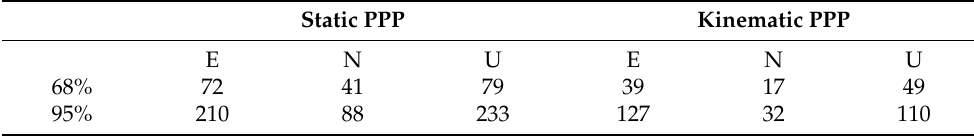
Table 10. Convergence time of the QF method (unit: min)